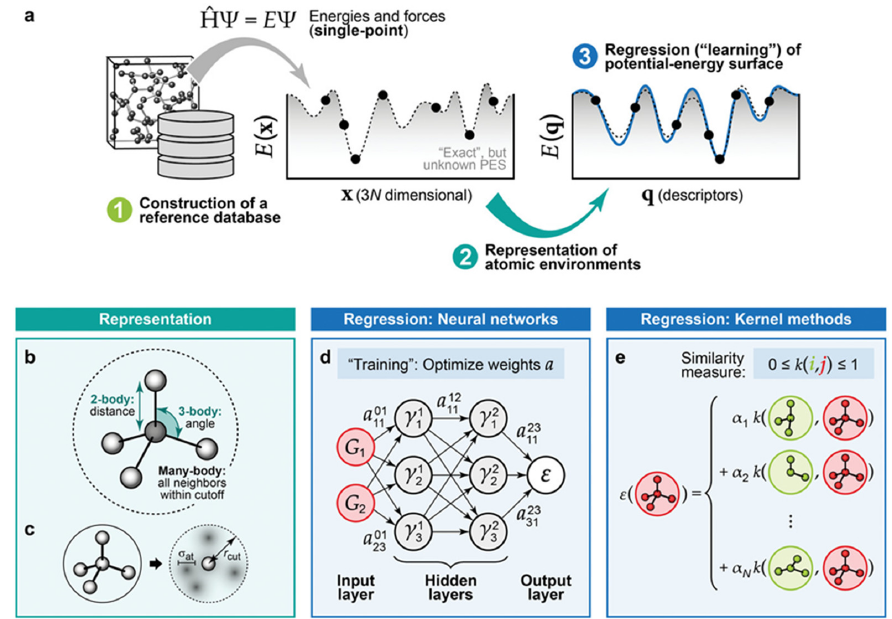
Figure 7. ( a ) A simple flow chart of machine learning potentials [129]. ( b , c ) Descriptors of empirical interatomic potentials and machine learning potentials. Two different models: ( d ) neural networks and ( e ) kernel methods. Copyright 2019, Advanced Materials.